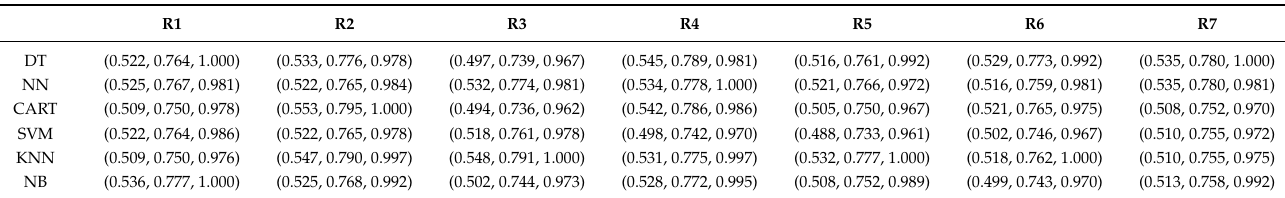
Table 5. A normalized judgment matrix.